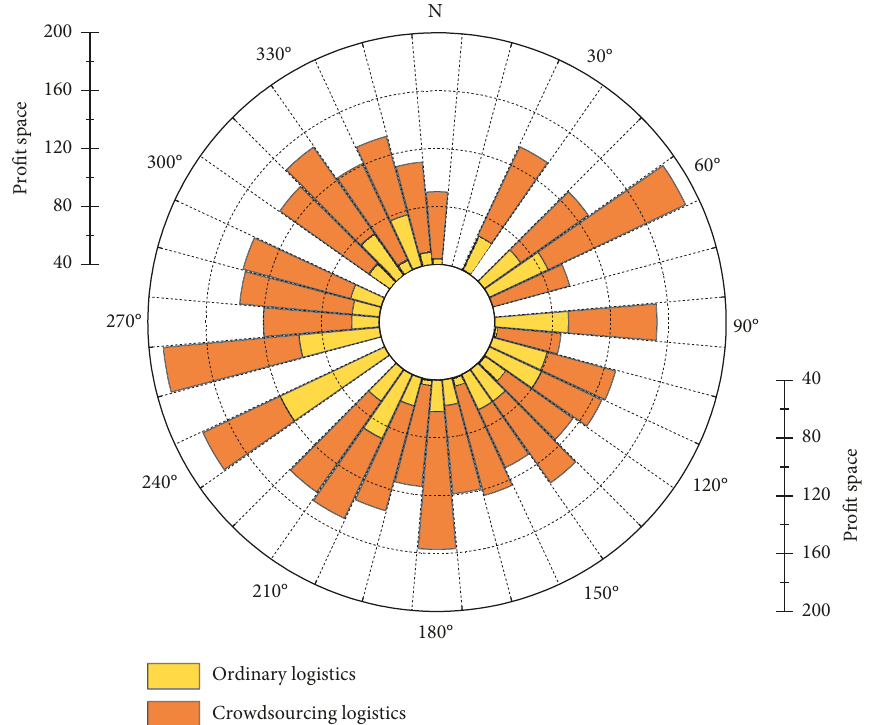
Figure 3: Rose comparison chart of profit space between crowdsourcing logistics and ordinary